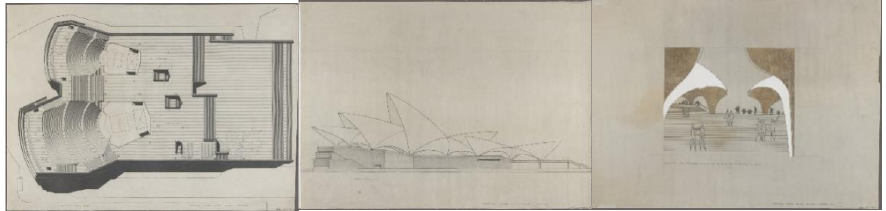
Figure 5. Original competition drawings for which the assessors of the Committee awarded Jørn Utzon first prize of GBP 5000 on 29 January 1957 (www.records.nsw.gov.au; last accessed 27 September 2021) [21].